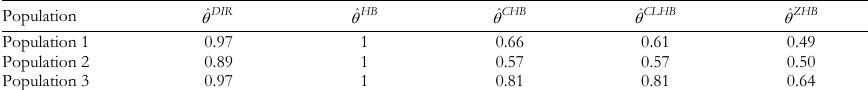
Ratio of the Kolmogorov-Smirnov distances between estimated and actual EDF averaged over MC replications divided by the same quantity calculated for the ˆ HB  estimators, i.e.